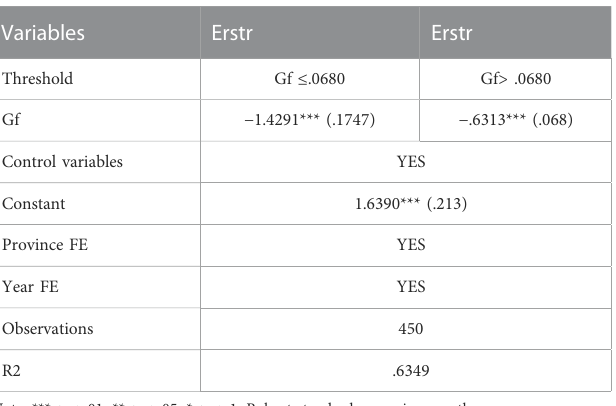
TABLE 9 Threshold regression results. TABLE 10 The role of government and market.